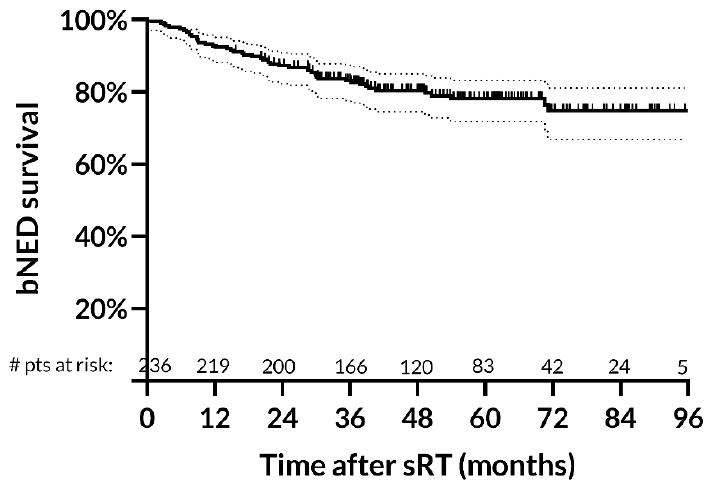
Figure 2. Biochemical survival rates after salvage radiotherapy. Four-year biochemical control rate is 80.4% (95% CI: 74.5–85.1%). Abbreviations: bNED: biochemical no evidence of disease; sRT: salv- age radiotherapy. Table 2. Multivariable Analysis. Positive vs. Negative DCE-MRI Disease Location at